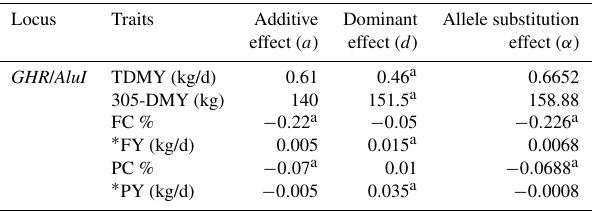
Table 5. Genetic effects of GHR / AluI polymorphism on milk- related traits in Holstein breed.